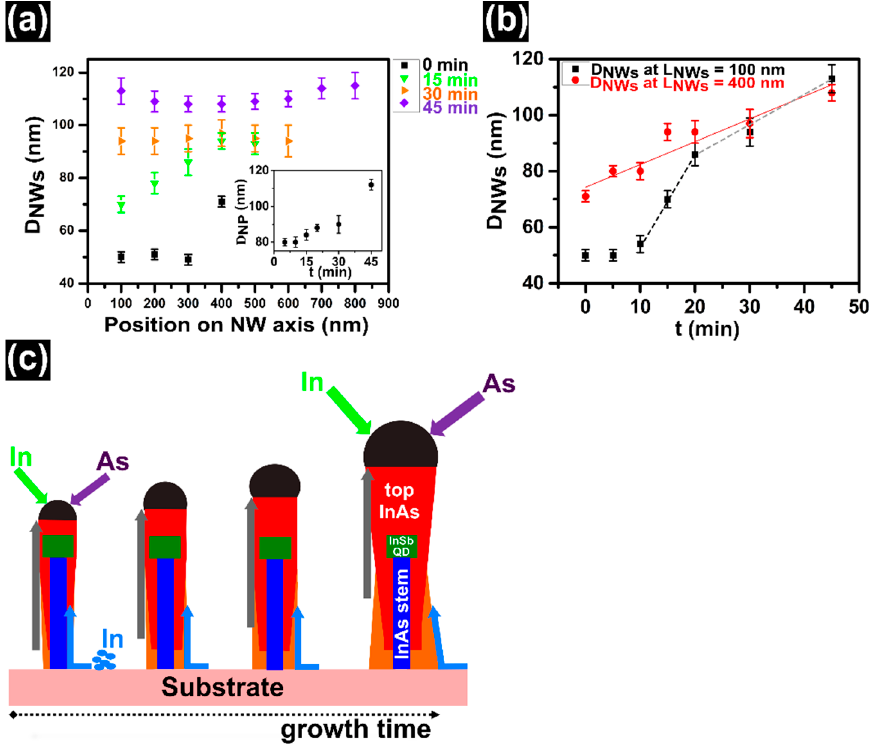
Figure 5. ( a ) NW diameter as a function of position along the length of NW, for 0, 15, 30 and 45 min samples of the time series shown in Figure 3a. The inset of panel ( a ) shows the relationship between D NP and growth time. ( b ) Evolution of the diameter of NWs at the base of NWs ( L NWs 100 ± 4 nm) and around the InSb QD ( L NWs 400 ± 4 nm) with respect to the growth time. The red line represents the linear fit of the D InSb versus time, while the black and grey dotted lines are just to guide the eye and highlight the change of slope. ( c ) A schematic illustration of the growth mechanisms for the radial growth (the blue and gray arrows indicate the two In adatom diffusion paths, from the substrate and from the NW sidewall within a diffusion length from the NP, respectively) and the resulting shape of the NWs versus growth